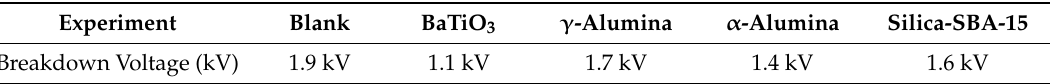
Table 3. The breakdown voltage for the Blank and the packed reactor obtained from Lissajous